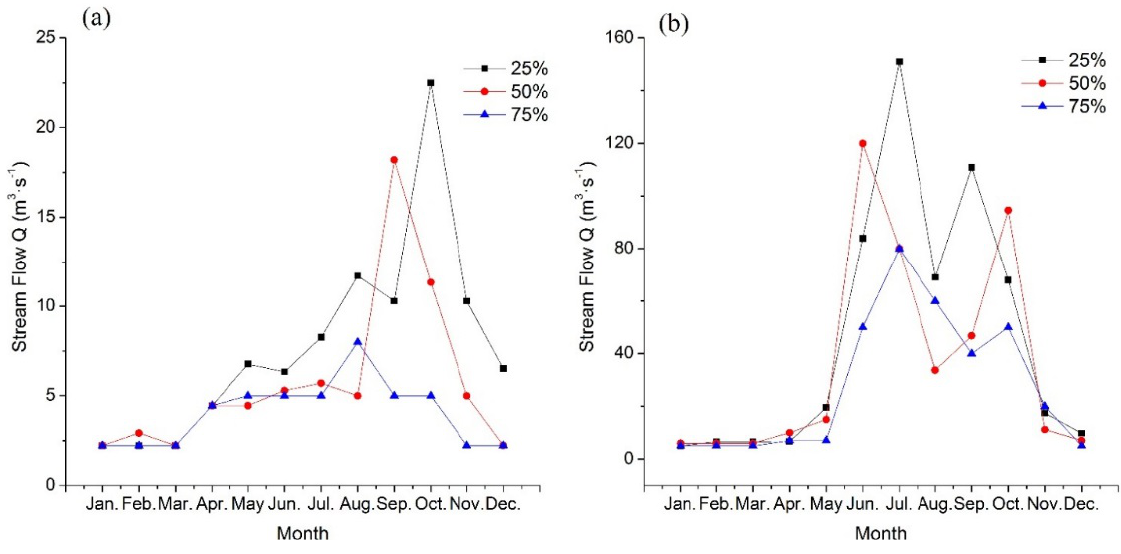
Figure 4. Runoff distribution results for three inflow hydrological years of Zhanyi Station ( a ) and Xiqiao Station ( b